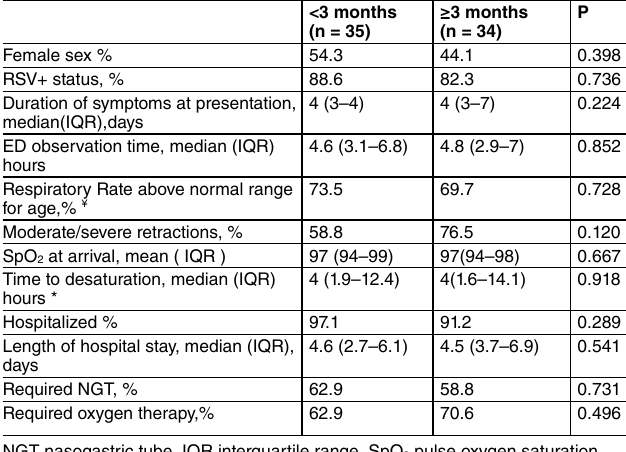
Table 1: Characteristics of study patients and outcome according to